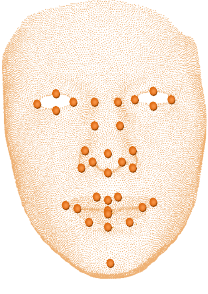
Fig. 6 Ground truth facial landmarks for one example in the B3D(AC) 2